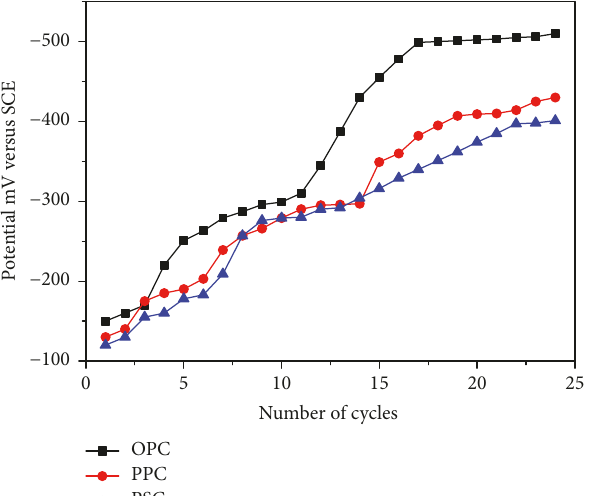
Figure 11: Potential versus number of cycles of exposure for rebar in OPC, PPC, and PSC M40 grade concrete types (90-day cured specimens) under macrocell